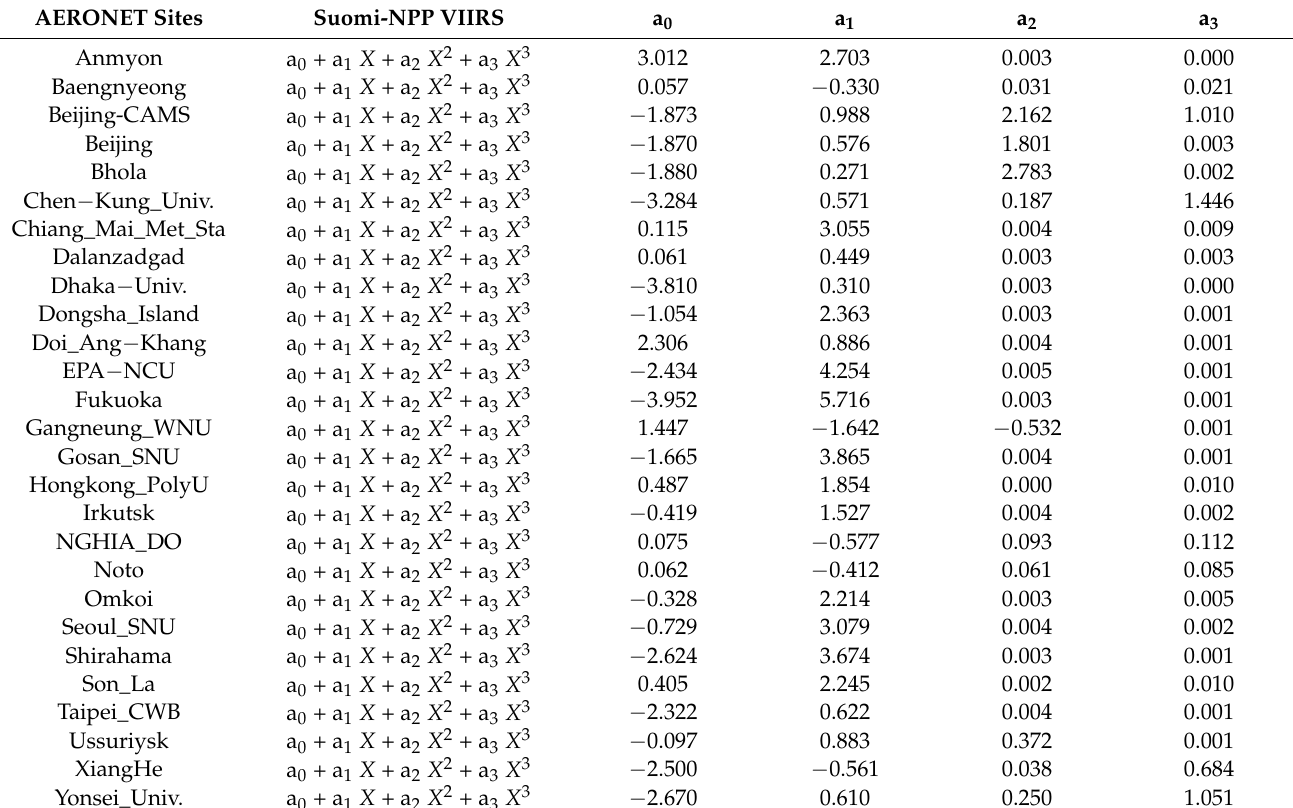
Table A4. Summary coefficients of Suomi-NPP/VIIRS AOD products during 2016 in training data ( X = AOD